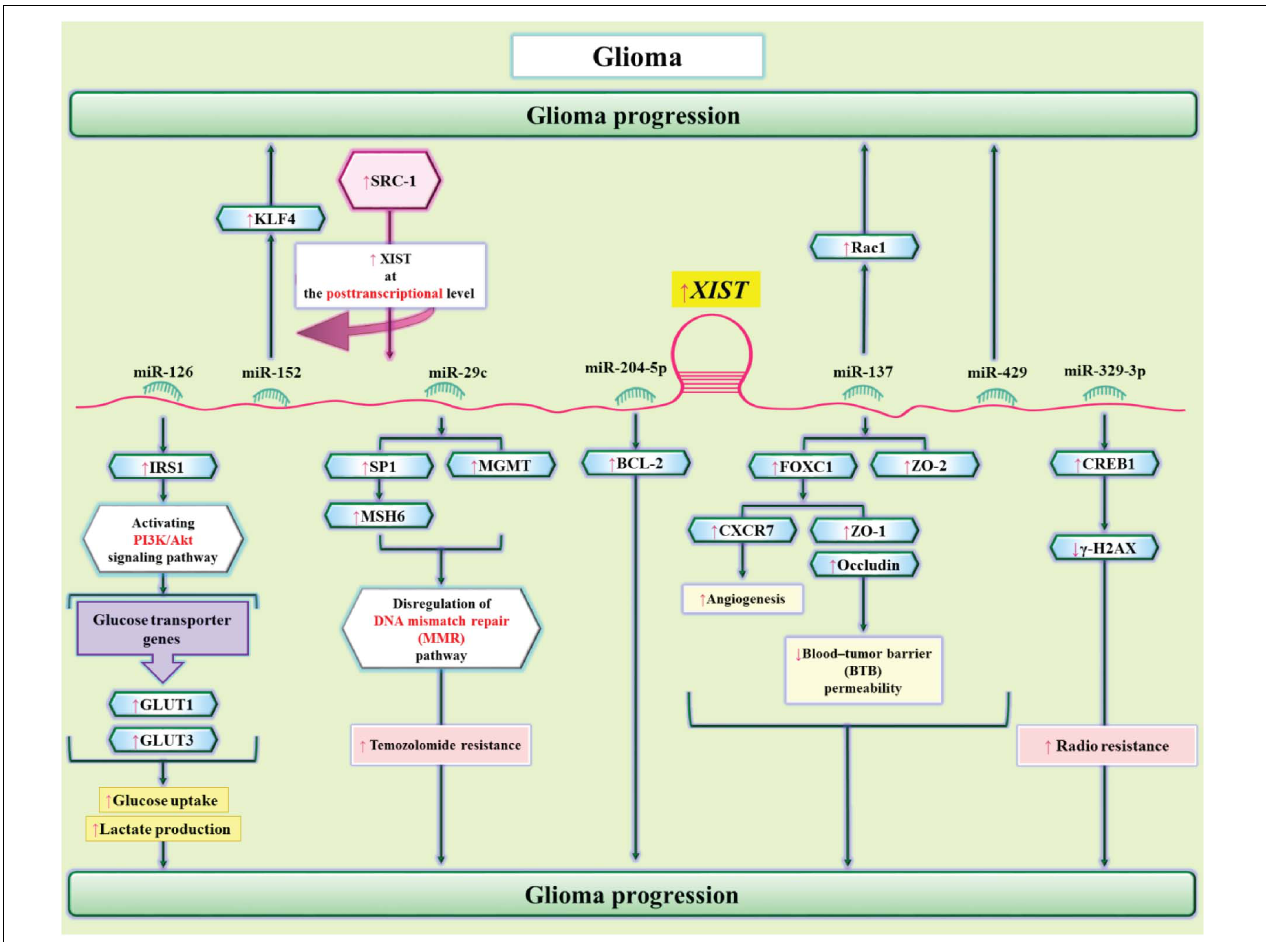
FIGURE 6 | The interactions between XIST and miRNAs in glioma cells. XIST enhances glioma tumorigenic capacity and angiogenesis through sequestering miR-429 (Cheng et al., 2017). In addition, through sequestering miR-126, XIST regulates cell proliferation and glucose metabolism of glioma cells via influencing IRS1/PI3K/Akt axis (Cheng et al., 2020). The sponging effect of XIST on miR-29c modulates resistance of glioma cell to Temozolomide via DNA mismatch repair pathway (Du et al.,